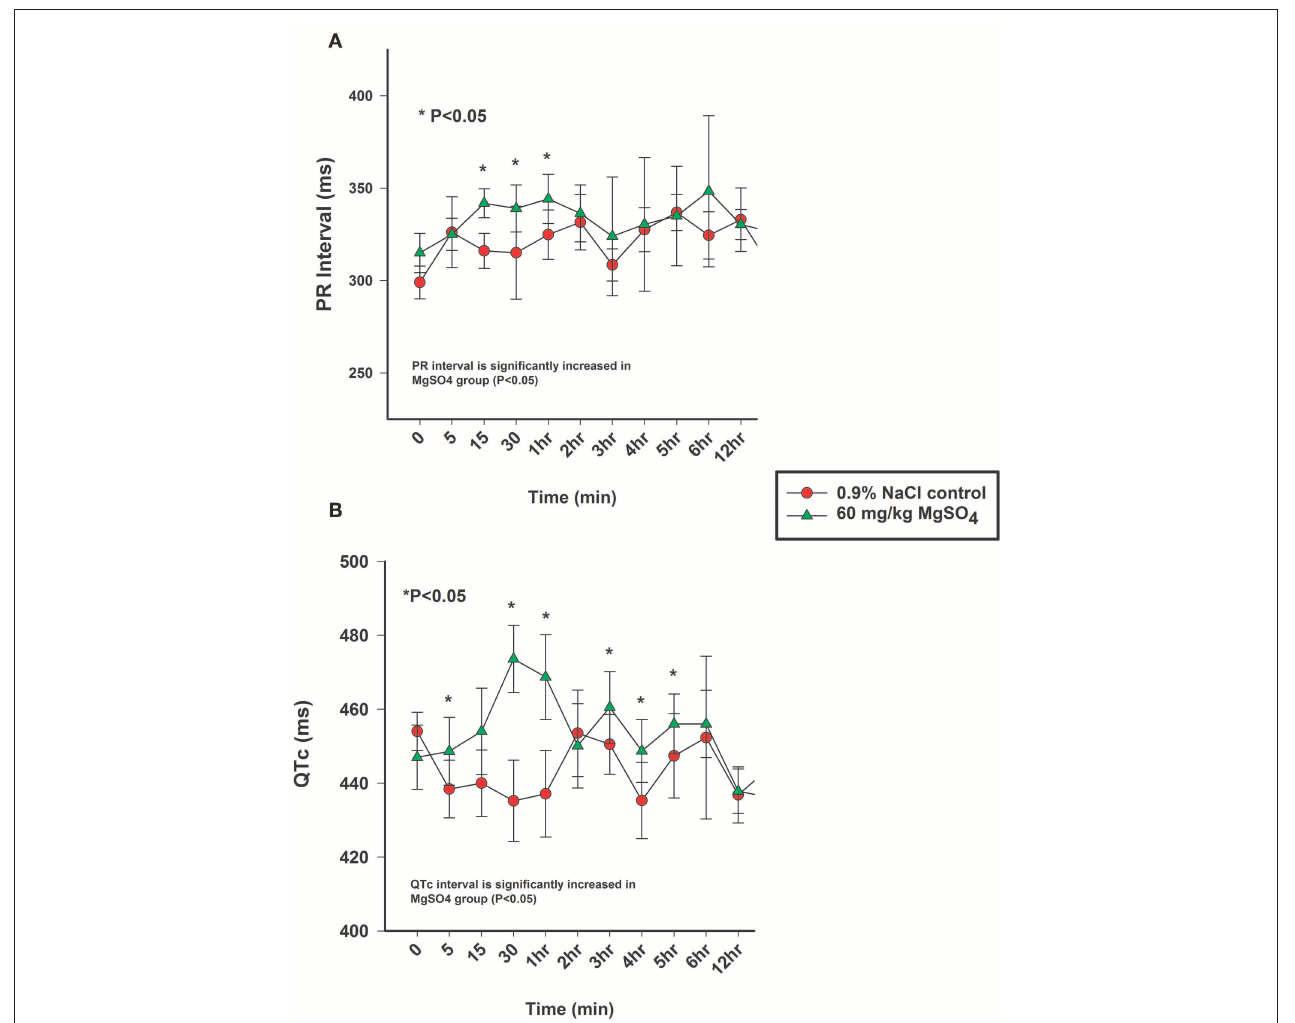
FIGURE 6 | (A) PR interval (ms) and (B) QTc intervals (ms) from the analysis of electrocardiograms from horses administered intravenously 60 mg/kg MgSO 4 (green triangles) and equivalent volume of 0.9% NaCl (red circles). Results are presented as mean ± SE (* P < 0.05).